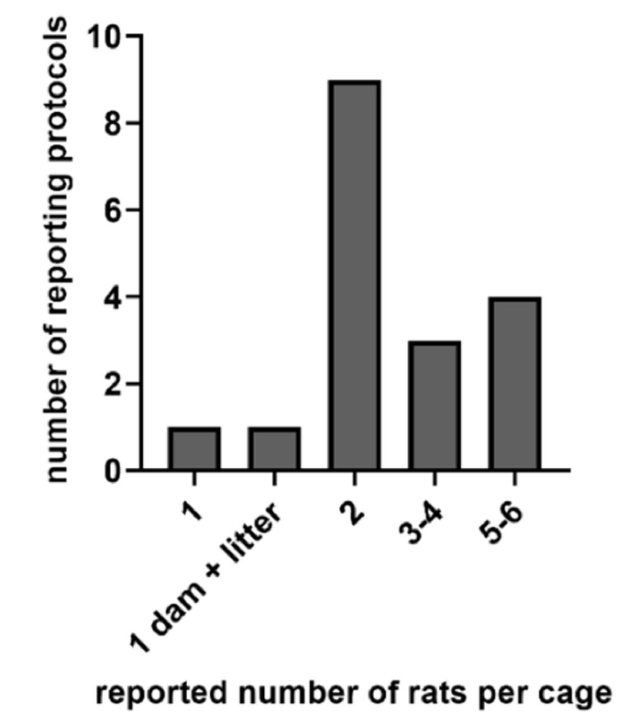
Figure 2. The number of rats per home cage housed in the animal facility, as reported by the researchers in the